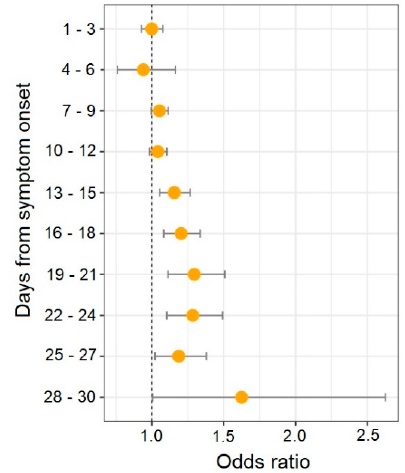
Figure 2. Serial changes in blood-cell-count- and CRP-derived inflammatory indices in COVID-19 patients. p -values less than 0.05 are indicated.